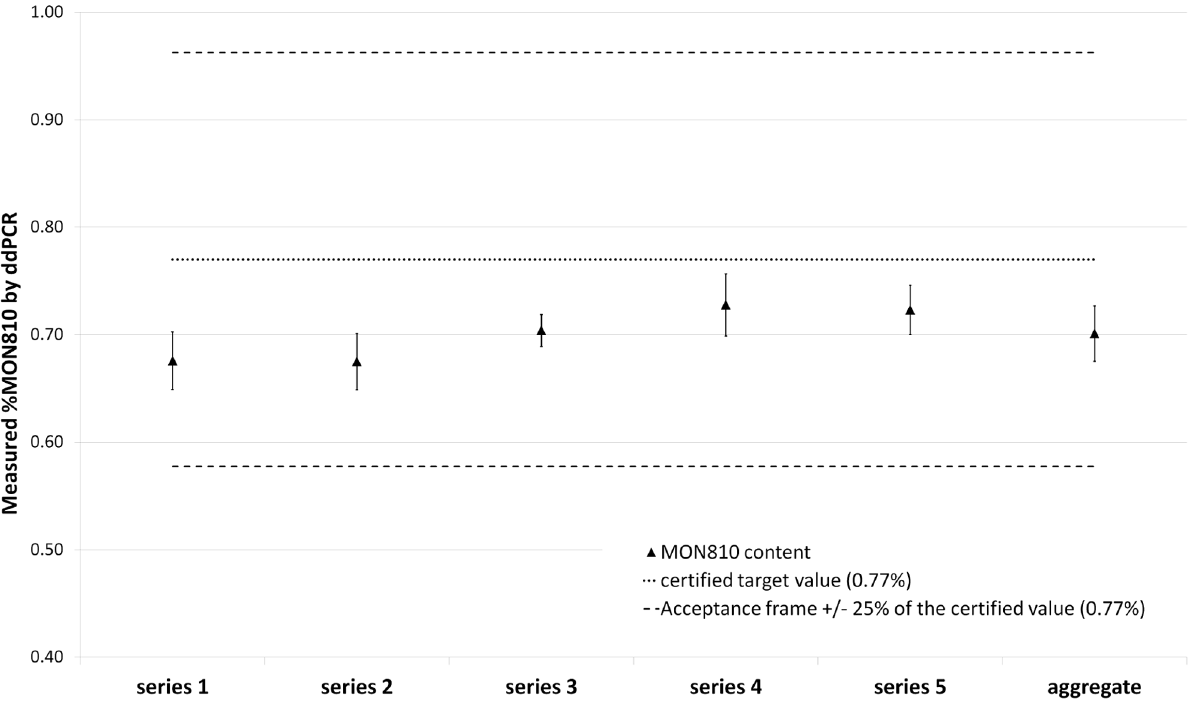
Figure 2. Repeatability results of the ddPCR duplex assay. MON810 content measured by ddPCR in five series of seven replicates. The aggregate represents the sum of the five series. The target certified MON810 content (0.77%) is indicated by a dotted line. Acceptance criterion for repeatability is 6 25% of the target content (from 0.58% to 0.96%) represented by the dashed lines. Error bars represent the standard deviation between the replicates for each series or in the aggregate. doi:10.1371/journal.pone.0062583.g002 During qPCR tests, we detected the presence of inhibition in the stock DNA solution of two samples (wheat seed-powder flour with maize contamination and maize feed), as indicated by the large differences in MON810 content (cv . 25%) calculated from